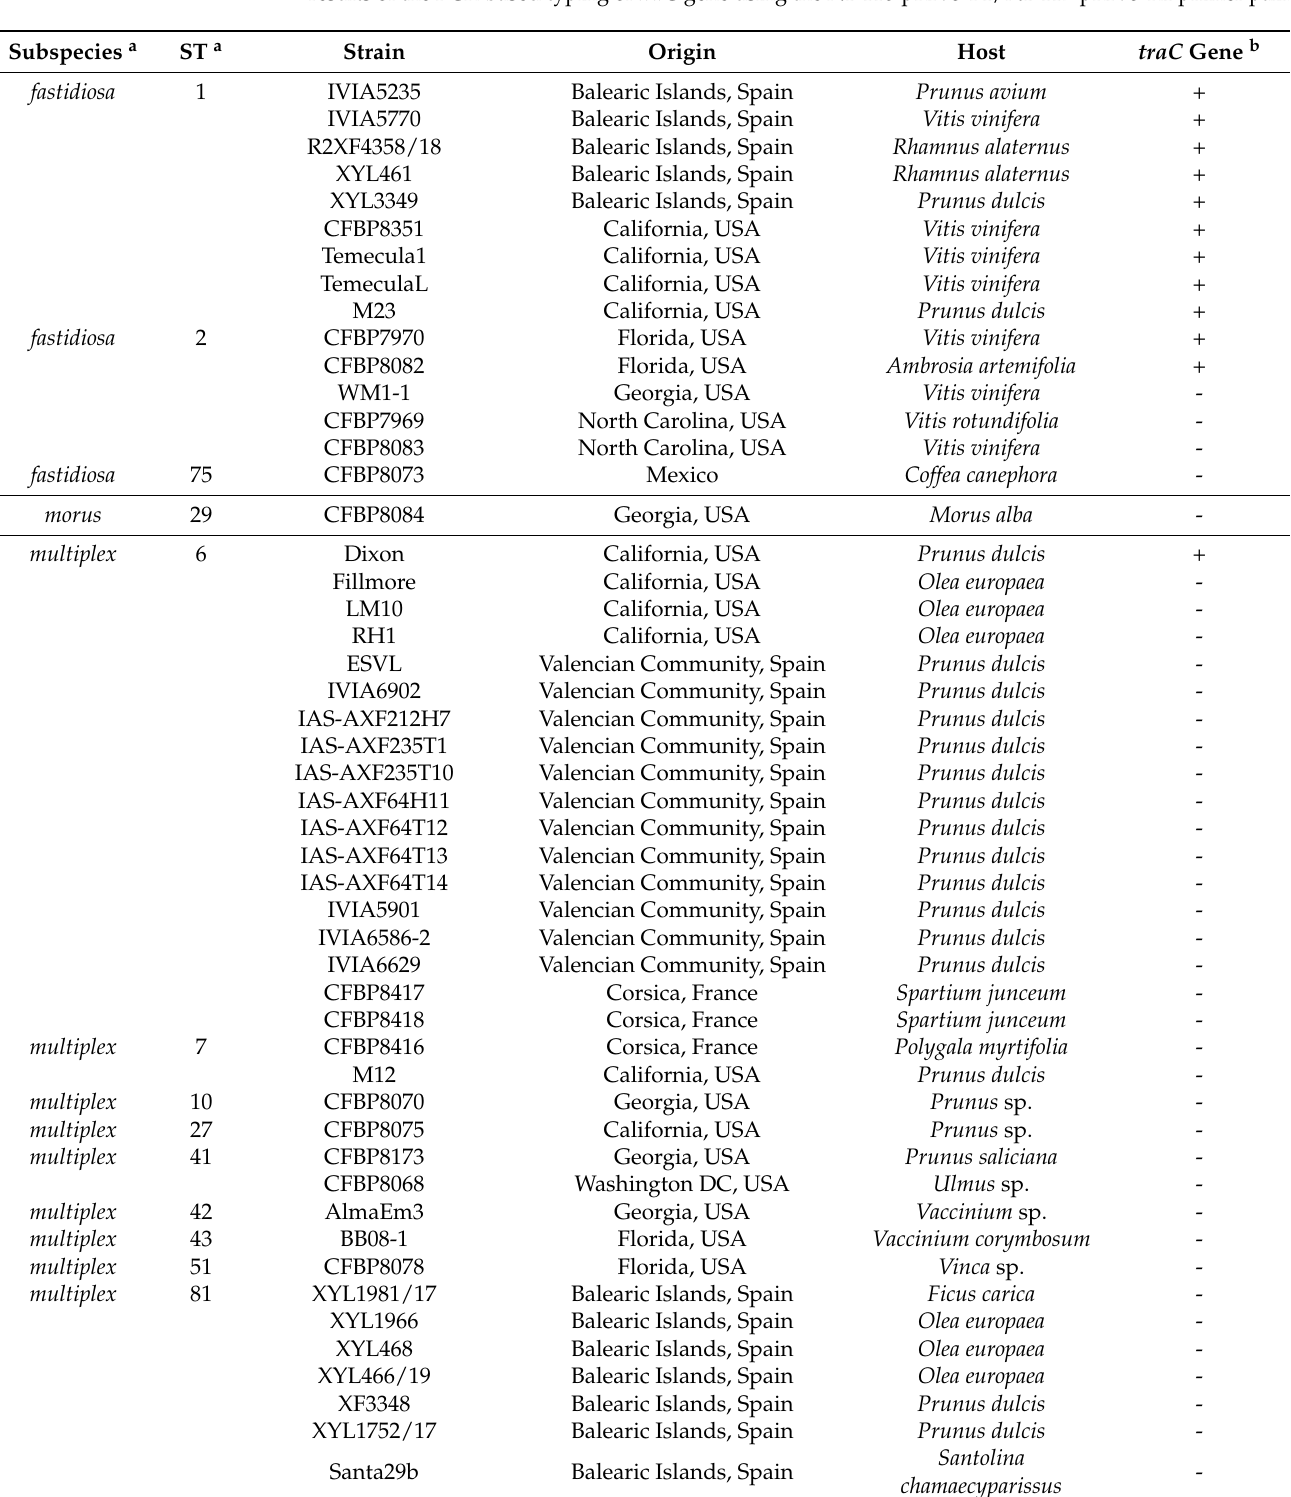
Table 1. Xylella fastidiosa strain collection at the Institute of Sustainable Agriculture, C ó rdoba, Spain (IAS-CSIC) used in the study, which include different subspecies and sequence types (ST) and the results of the PCR-based typing of tra C gene using the ND116-pRIV5-F1/ND117-pRIV5-R1 primer